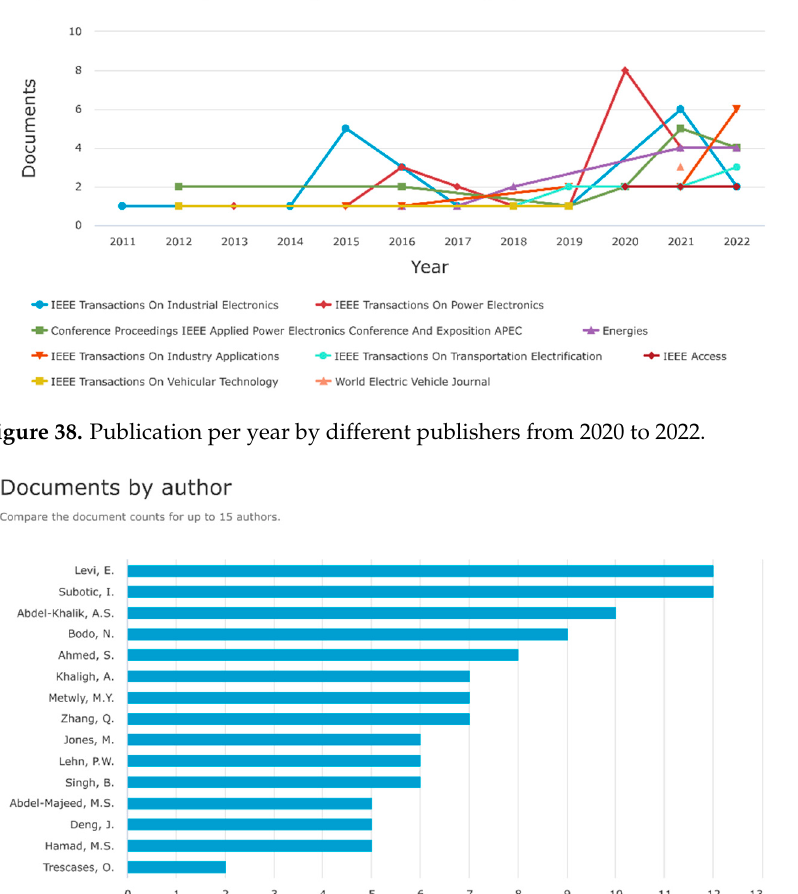
Figure 40. Publication status of top 15 higher educational institutions for iOBC for electric vehicles from 2010 to until 2022. 8. Economic and Environmental Impact of iOBC